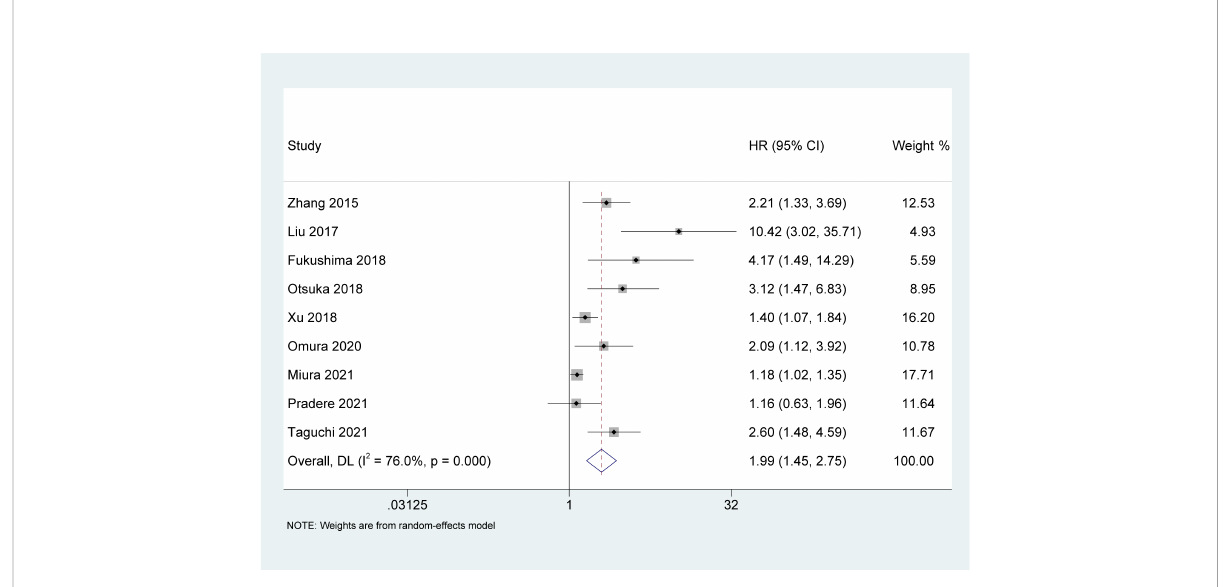
FIGURE 2 Forest plot and meta-analysis of the association between overall survival and albumin to globulin ratio.